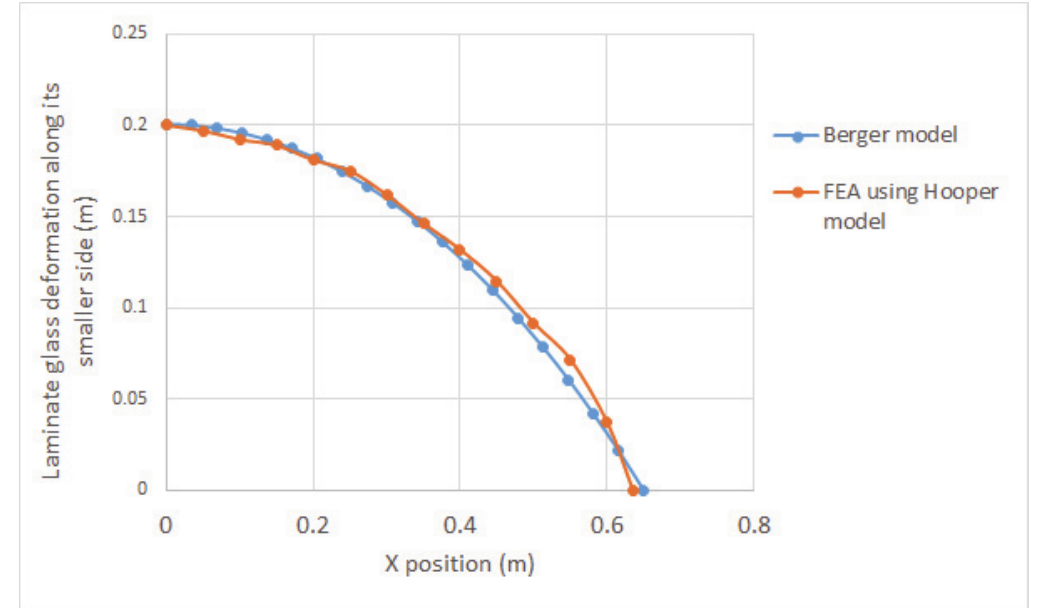
Fig. 7: comparison between the deformations along the small glass side calculated at the moment of the second peak of maximum deformation using the Hooper FEA model and the Berger relation (thin plate defection under static load).